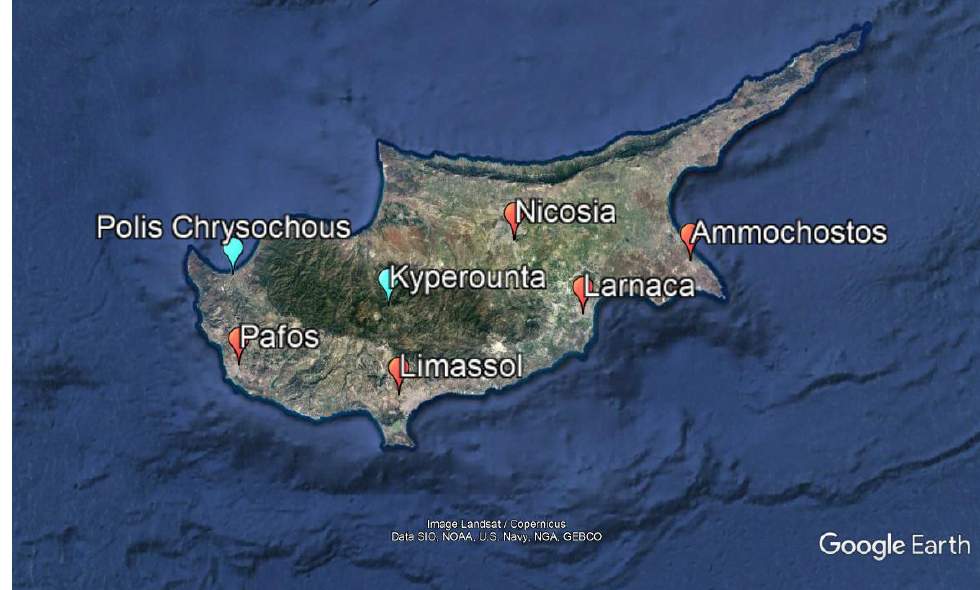
Figure 1. Map of Cyprus and locations of general (red dots) and rural (blue dots) hospitals. Nicosia city (Nicosia district) hosts two general hospitals (i.e., the Nicosia General Hospital and the General Hospital for Children Makario). The rural hospital of Polis Chrysochous is located in the Pafos district and of Kyperounta in the Limassol district.